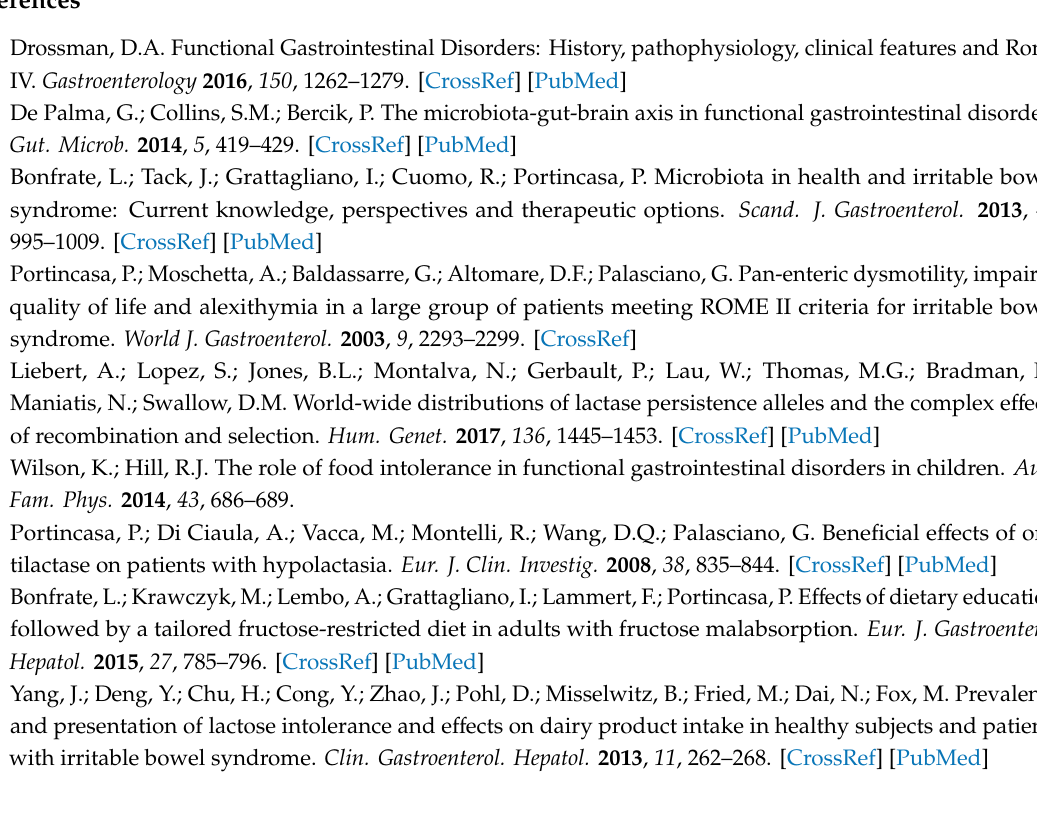
Supplementary Materials: The following are available online at: http: // www.mdpi.com / 2072-6643 / 11 / 4 / 886 / s1. Figure S1: Representation of abdominal pain (VAS 0–100 nm) in 23 patients at baseline (T0) and after 30 days (T30) of treatment (ZR) and placebo (PL) by spaghetti graft. Figure S2: Representation of Bristol Score (1–7) at baseline (T0) in 23 patients and after 30 days (T30) of treatment (ZR) and placebo (PL) by spaghetti graft. Table S1: Amounts of daily micro / macronutrients at baseline. Table S2: Changes of gastrointestinal symptoms and bowel habits in placebo (PL) and treatment (ZR) according to sequence (1 = Placebo / ZR and 2 = ZR / Placebo) and globally. Table S3: Median values and range of cultivable of bacterial cells (log CFU / g) of the main microbial groups in the faecal samples of lactose intolerant patients at baseline (T0), after 30 days of treatment (ZR) or Placebo